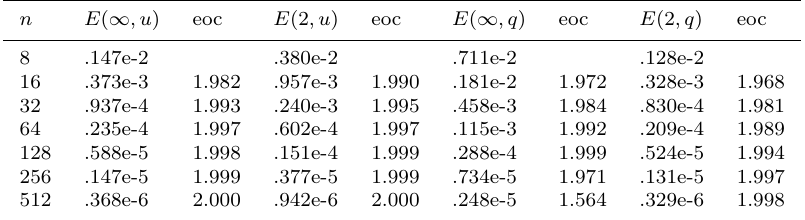
Table 3. Errors and orders of convergence of the P 1 − collocation on the circular arc n